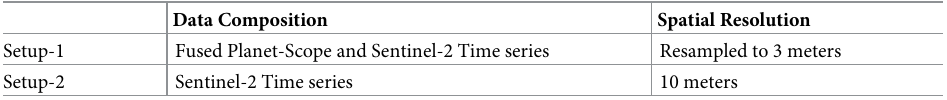
Table 1. Experimental setups.